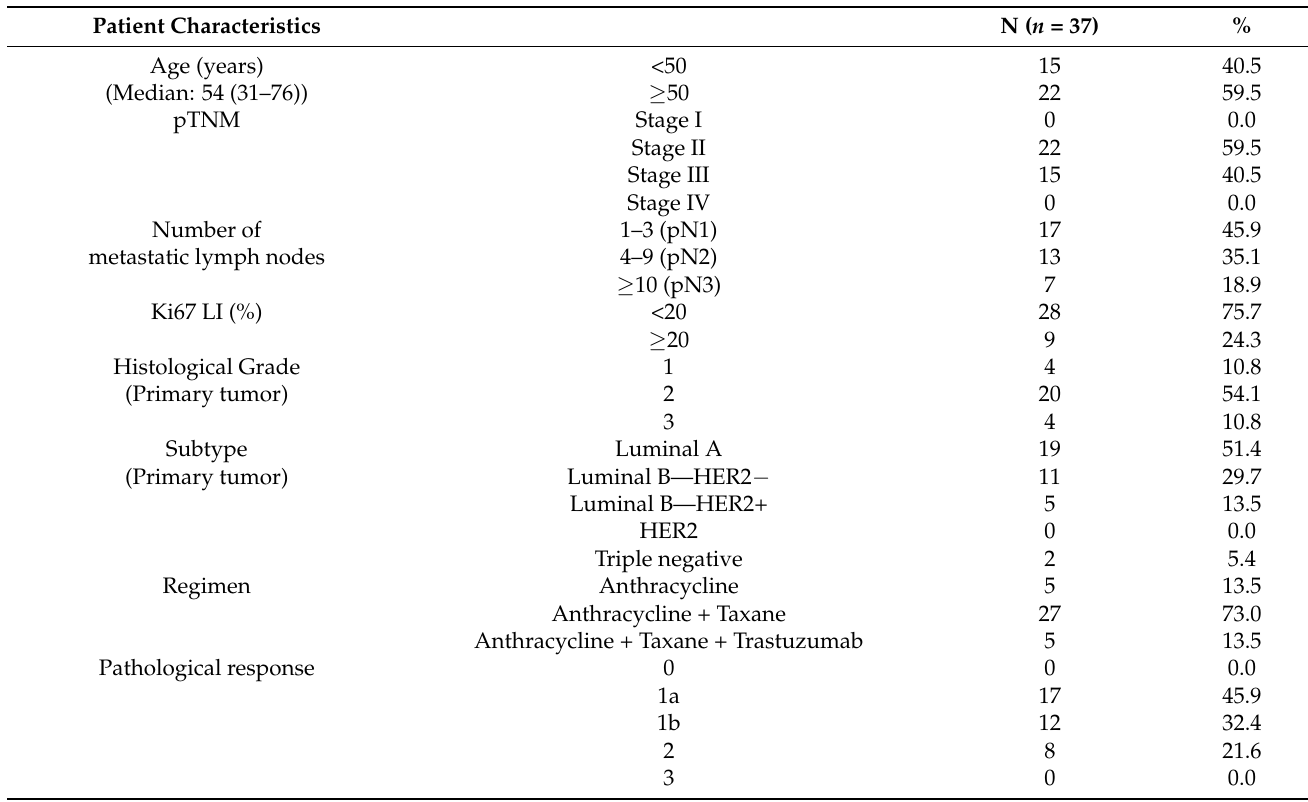
Table 1. Clinicopathological patient